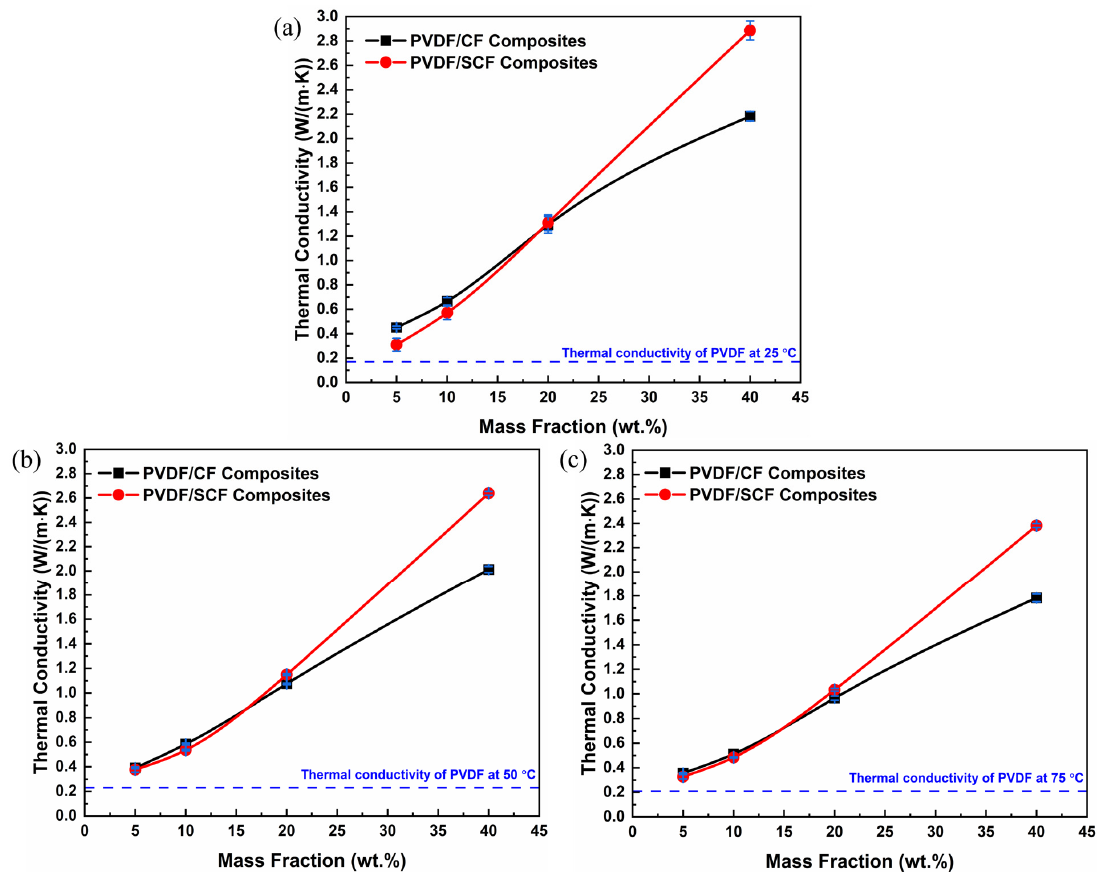
Figure 5. Thermal conductivities of the PVDF/CF and PVDF/SCF composites at ( a ) 25, ( b ) 50, and ( c ) 75 °C, respectively. ( c ) 75 ◦ C,